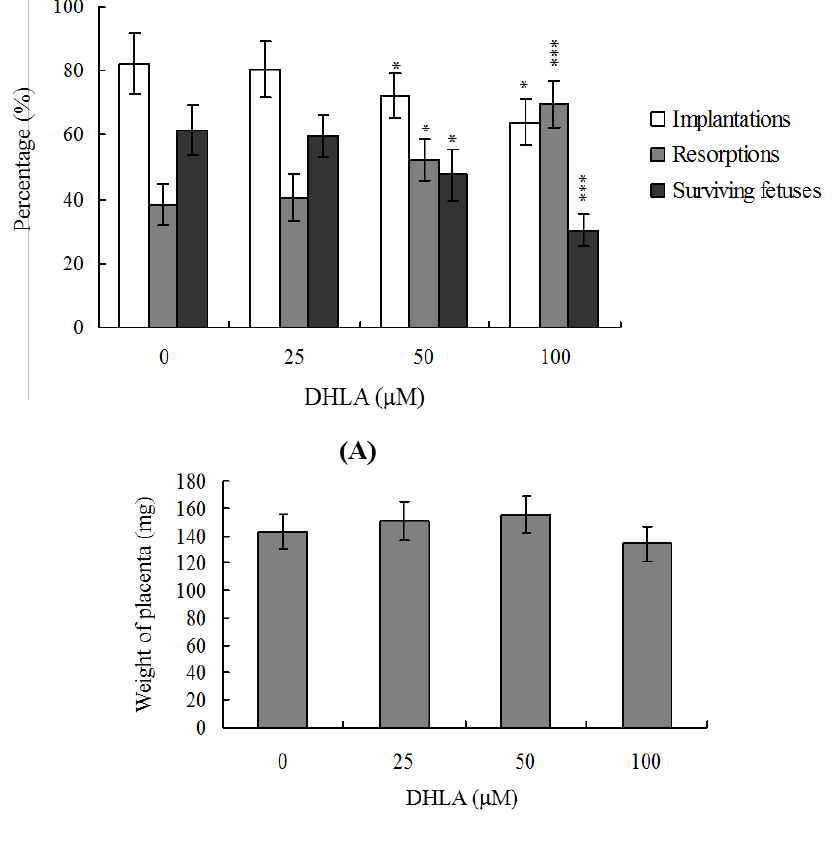
Figure 4. Effects of DHLA on in vivo implantation, resorption, fetal survival and fetal weights of mouse blastocysts. ( A ) Mouse blastocysts were treated with DHLA (25, 50 or 100 μM) for 24 h or left untreated. Implantations, resorptions and surviving fetuses were analyzed, as described in Materials and Methods. The percentage of implantations represents the number of implantations per number of transferred embryos × 100. The percentage of resorptions or surviving fetuses signifies the number of resorptions or surviving fetuses per number of implantations × 100; ( B ) Placental weights of 40 recipient mice were measured; ( C ) Weight distribution of surviving fetuses on day 18 post-coitus. Surviving fetuses were obtained by embryo transfer of control and DHLA-pretreated blastocysts, as described in Materials and Methods (320 total blastocysts across 40 recipients). * P < 0.05 and *** P < 0.001 versus the DHLA-free